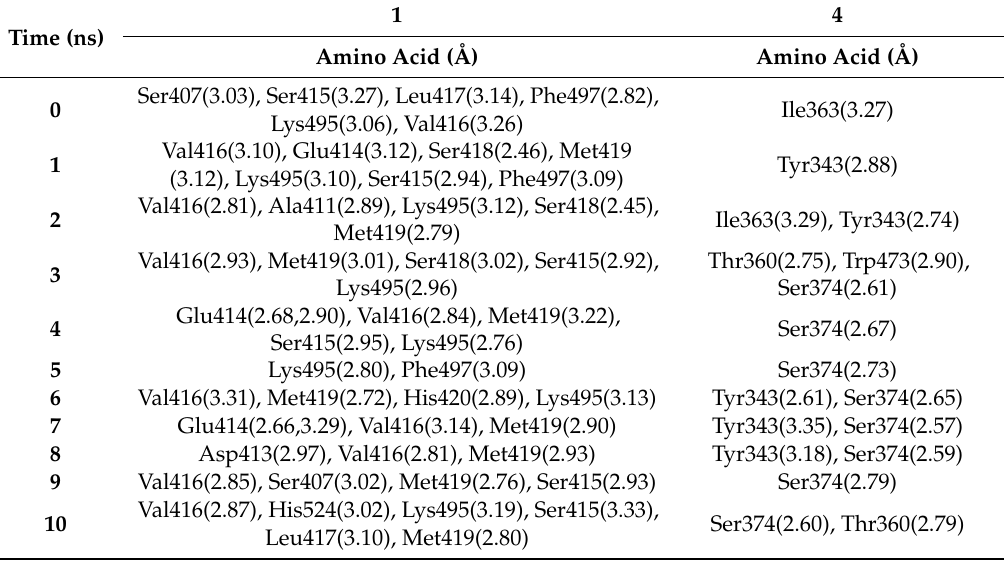
Table 3. Hydrogen bond analysis of the inhibitor with sEH at 1-ns intervals for 10 ns.